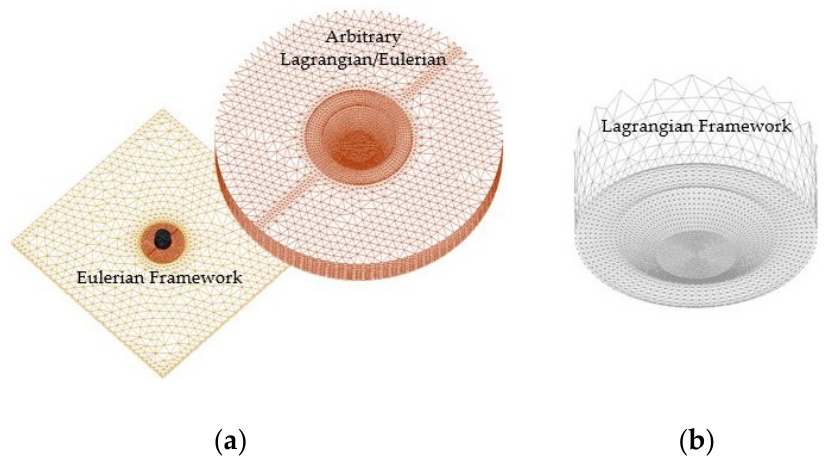
Figure 3. Model geometry and mesh discretisation: ( a ) workpiece and ( b ) tool.